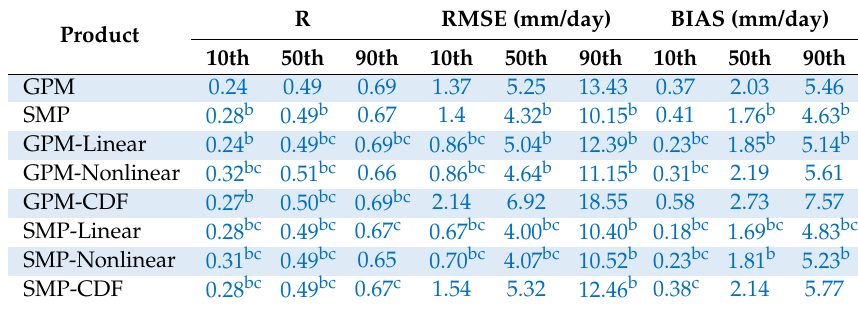
Table 2. Summary statistics of the spatial distribution of performance scores for the seven correction methods against